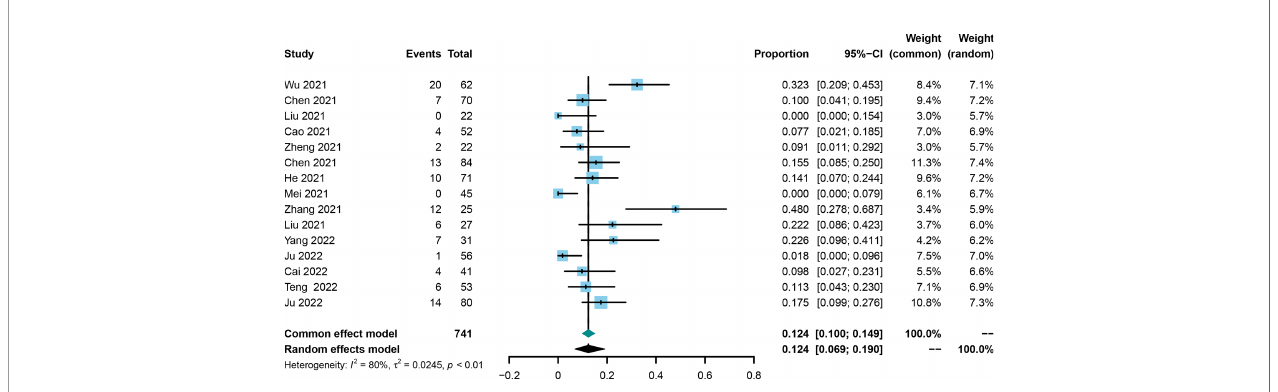
FIGURE 2 | Forest plot of the pooled complete